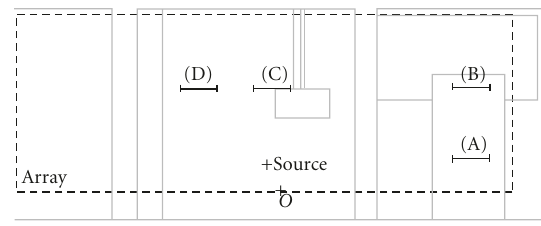
Figure 6: Extract of Figure 2 showing the positions of some of the cases